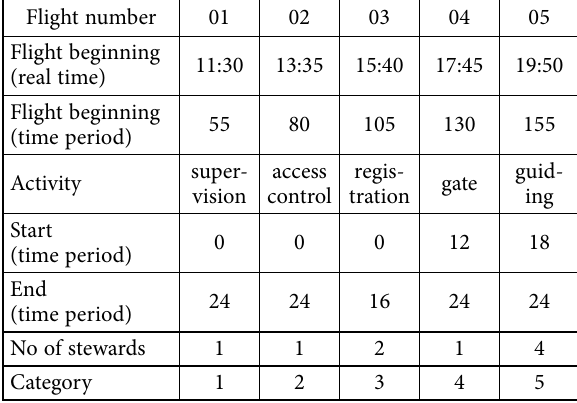
Table 3. The ranges of input data